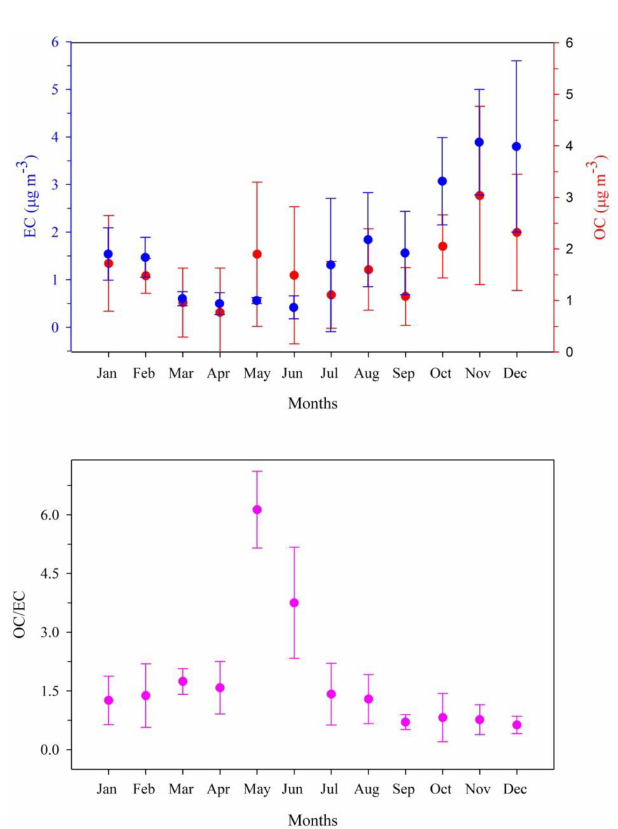
Figure 6. Monthly averaged EC and OC concentrations and the OC / EC ratios from Mt.